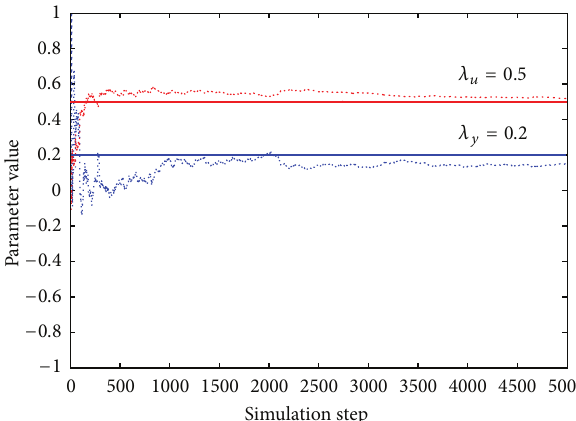
Figure 6: Estimation of 𝜆 𝑦 and 𝜆 𝑢 in System 3 with ARMA input process.